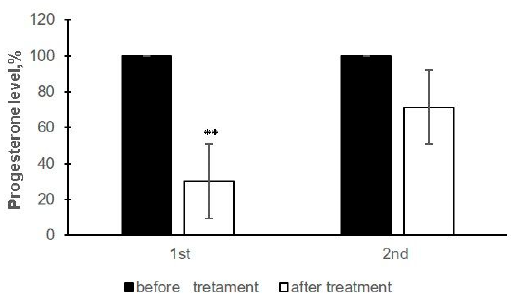
Figure 2. Relative change of progesterone level in blood serum of experimental Bulgarian Murrah buffaloes according to the number of treatments with AyuFertin supplement. The progesterone level before the first and second treatments was accepted as 100%. ** p < 0.01 compared to pre- treatment period.